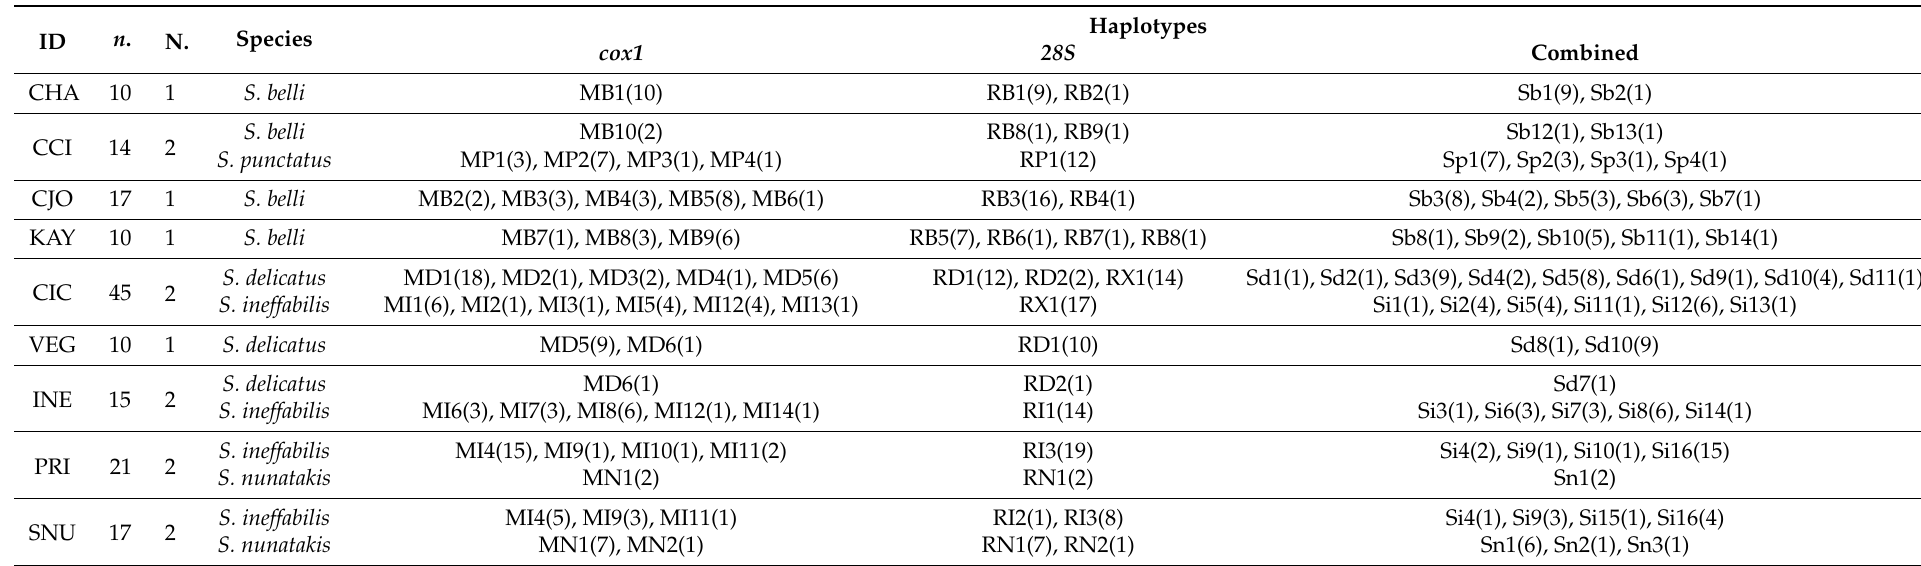
Table 5. Sampling locality codes (ID), number of sequenced individuals per area ( n .), number of species per area (N.) and their names, and list of all haplotypes for each species. Haplotype code: the first letter indicates the marker (M: mitochondrial; R: nuclear ribosomal DNA) and the genus (S: Stereotydeus ) in the combined haplotypes; the second letter is the initial of